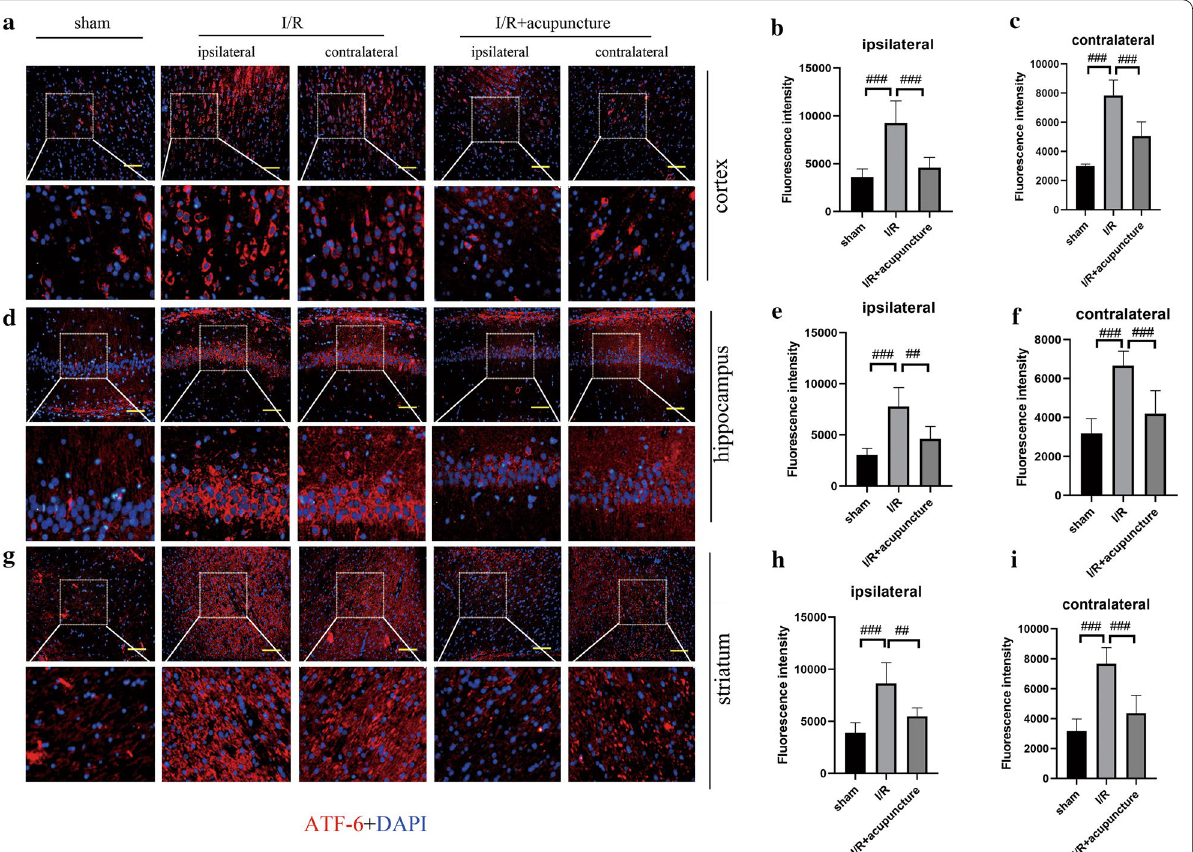
Fig. 4 Acupuncture repressed cerebral ischemia–reperfusion (I/R) injury-induced endoplasmic reticulum (ER) stress via inhibiting transcription factor 6 (ATF-6) expression. Immunofluorescence analysis of ATF-6 expression (red) in cortex ( a – c ), hippocampus ( d – f ), and striatum ( g – i ) of contralateral and ipsilateral brains at 72 h after reperfusion. The nuclei were counterstained with DAPI (blue). Scale bars, 100 μm. Results represent at least three independent experiments. Each experimental result was presented as